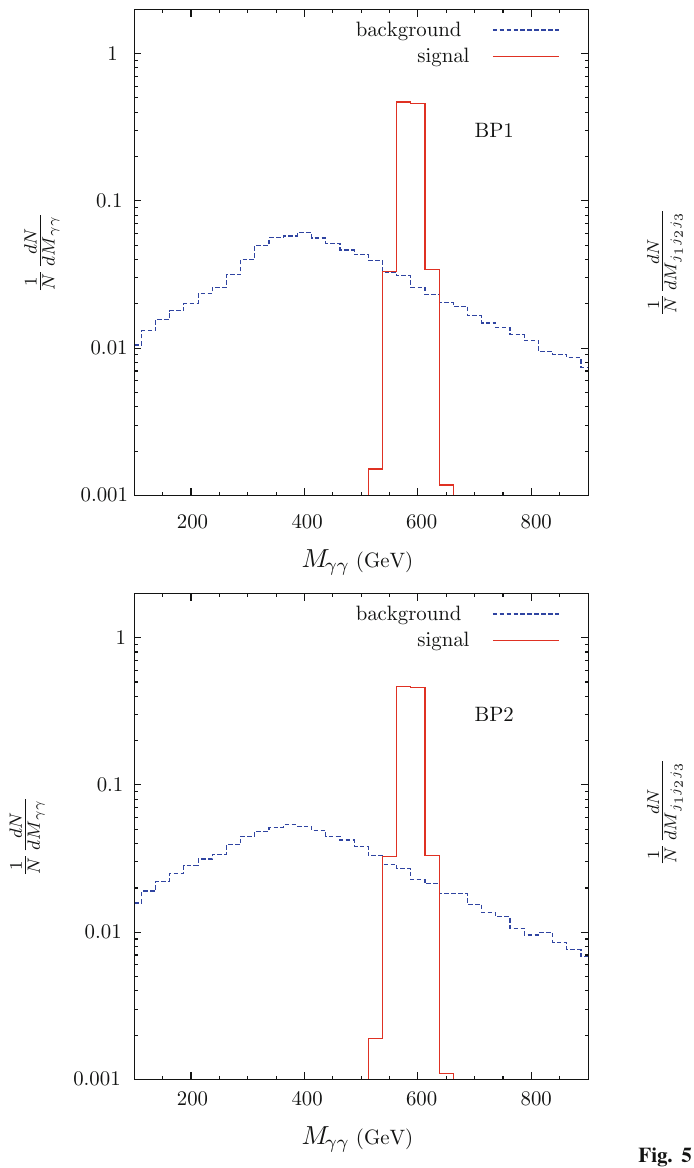
Fig. 4 The normalized invariant mass distributions for the two leading photons of benchmark scenarios BP1 and BP2